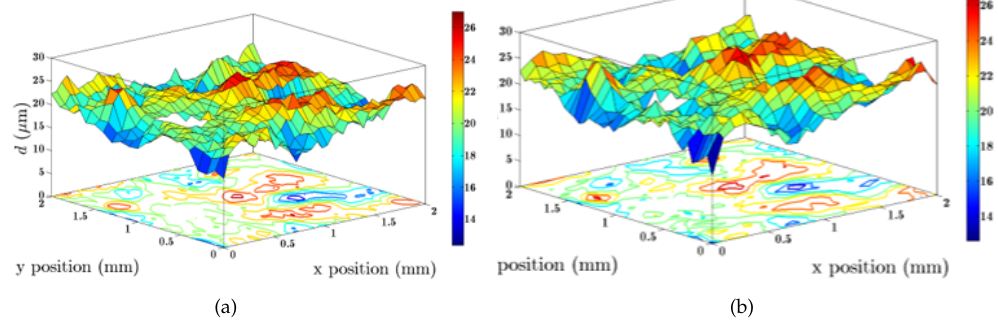
Figure 12. Surface plots of the best fitting coating thickness as measured by a XY ( a ) and YX ( b ) scan. Around x = 0.4 mm and y = 0.9 mm no results are shown due to lack of data at these positions. A large correlation between the two scans is